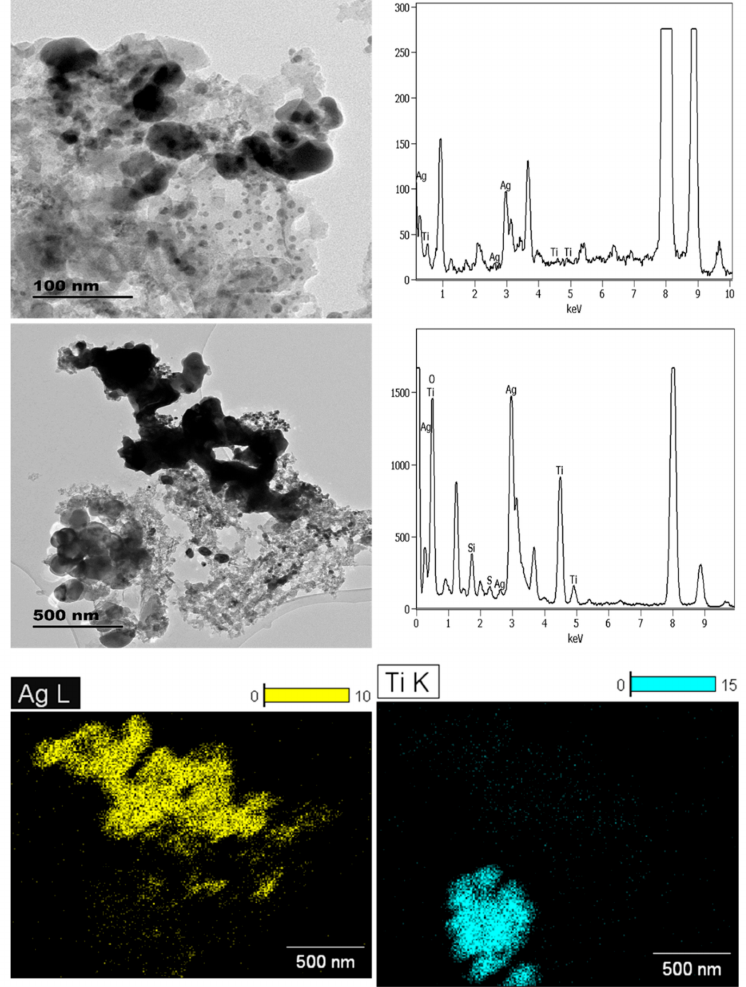
Figure 7. TEM-EDX analysis of ashed SK1 and elemental mapping showing the presence of nAg (yellow) and nTiO 2